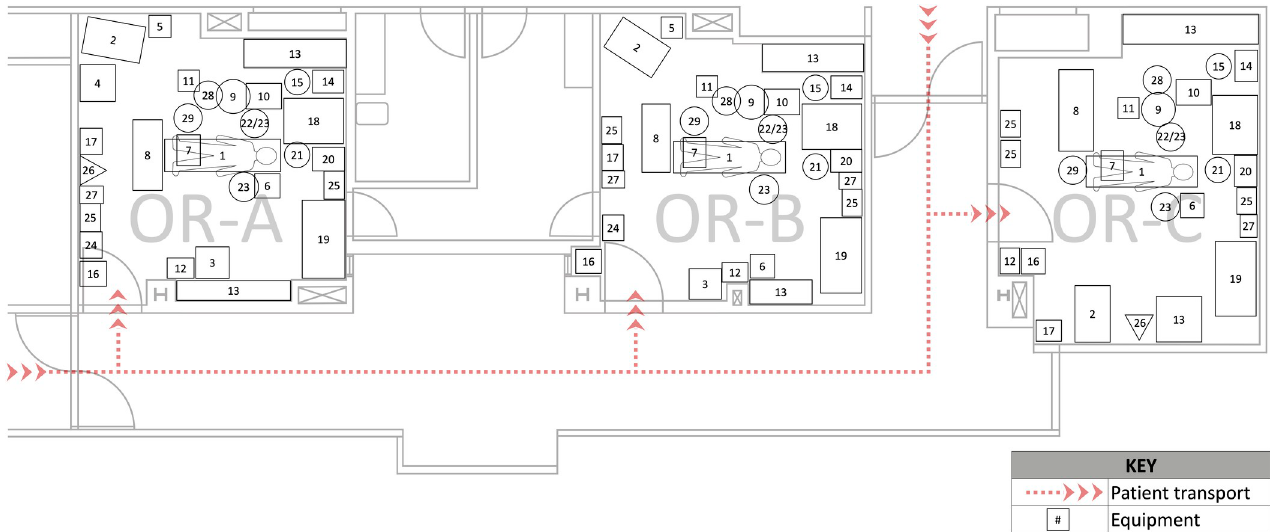
Fig 1. Layout and orientation of obstetric ORs and equipment. 1-OR table; 2-infant warmer; 3-oak cabinet or cart with fetal heart monitor; 4-neonatal code cart; 5-neonatal supplies cart; 6-support person chair; 7-mayo stand; 8-surgical back table; 9-suction apparatus; 10-electrocautery; 11-round bucket basin stand; 12-surgical steps; 13-built-in supply cabinet; 14-nurses’ computer workstation; 15-round rolling sitting stool; 16-hovermachine device; 17-prep stand for Foley; 18-anesthesia machine; 19-automated medication dispensing system; 20-anesthesia computer workstation; 21-anesthesiologist chair; 22-forced air